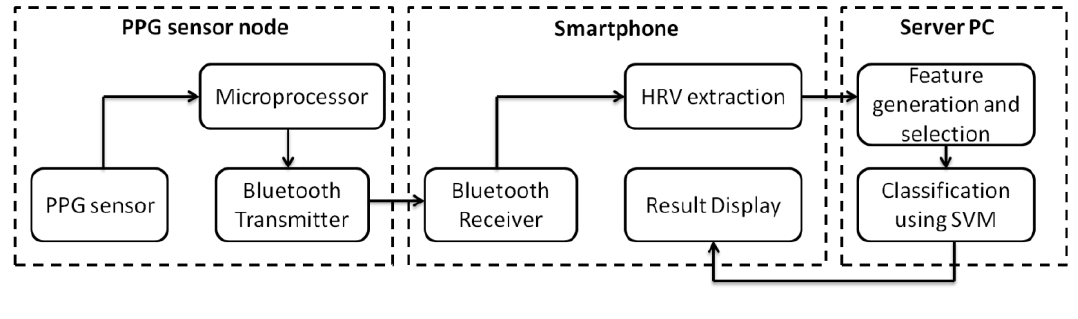
Figure 1. Schematic diagram of the proposed driver drowsiness detection system.